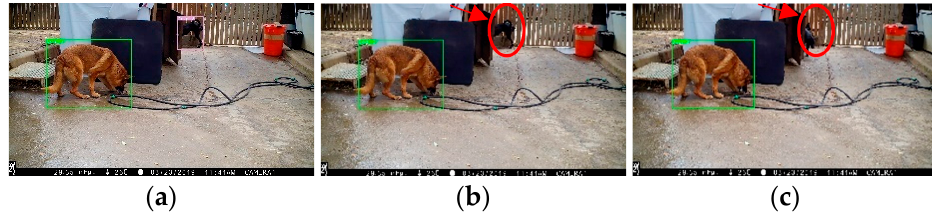
Figure 19. Dog with ID 2 not tracked from image 266 to 274. ( a ) Image 265; ( b ) Image 266; ( c ) Image 274.